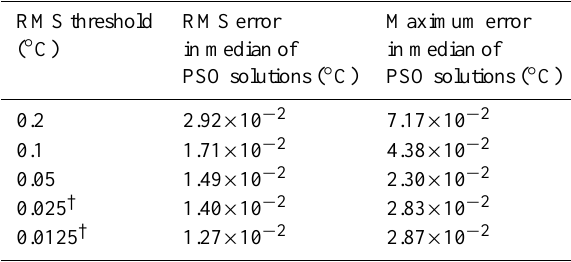
Table 3. Sensitivity of PSO median solution to the RMS